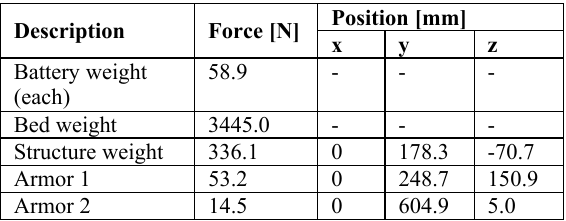
Table 2. Position and loads applied to the structure